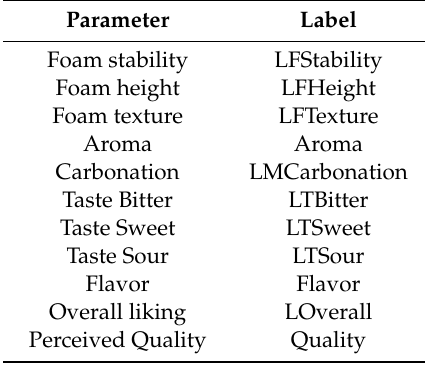
Table 4. Sensory attributes evaluated in the descriptive